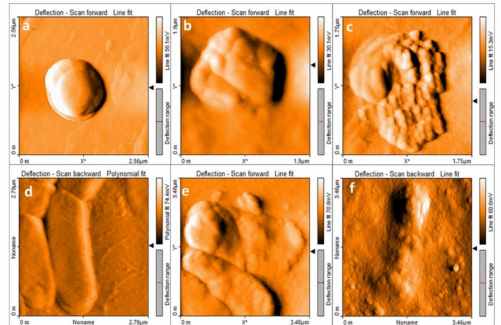
Figure 13. Atomic force microscopy (AFM) images obtained for the non-exposed S. aureus (panel a ) and those treated for 24 h with 250 (MIC) and 500 ppm MgO NPs (( b ) and ( c ), respectively). The non-treated E. coli is shown in panel ( d ), while panels ( e , f ) show those treated with 500 (MIC) and 1000 ppm MgO NPs,